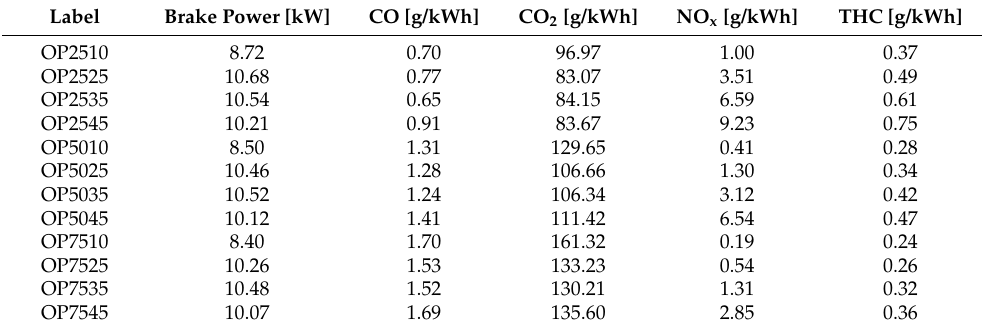
Table 8. Emissions [g/kWh] and brake power [kW] for each of the operating points according to its label (OPXXYY: OP = Operating Point, XX = SES, YY = spark advance; see Table 5). Label Brake Power